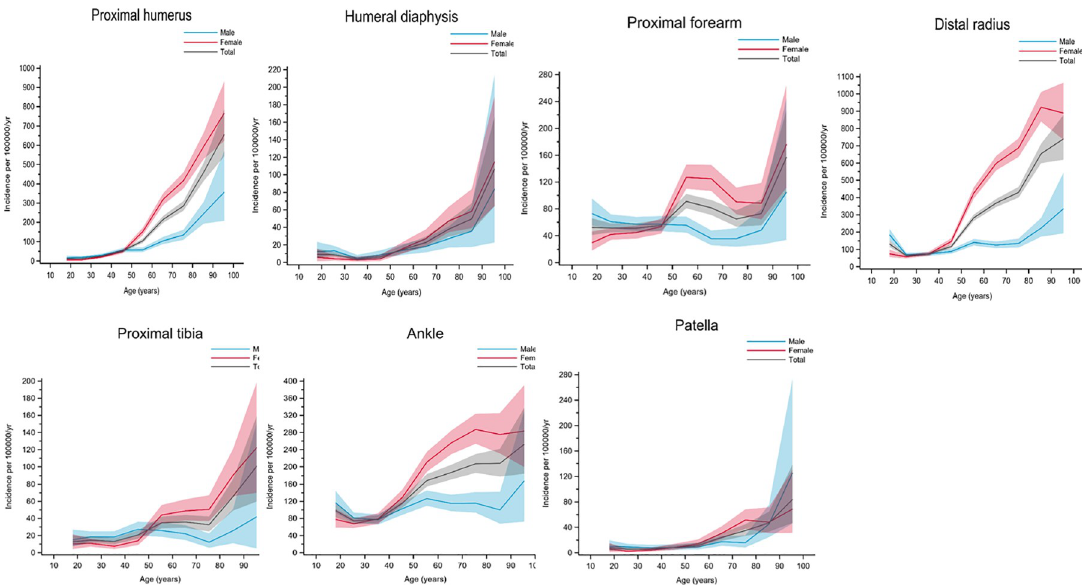
Fig 4. Fractures in group C. Age- and gender-specific incidence with 95% confidence interval. Black line represents the total population; red line represents females and blue line represents males.